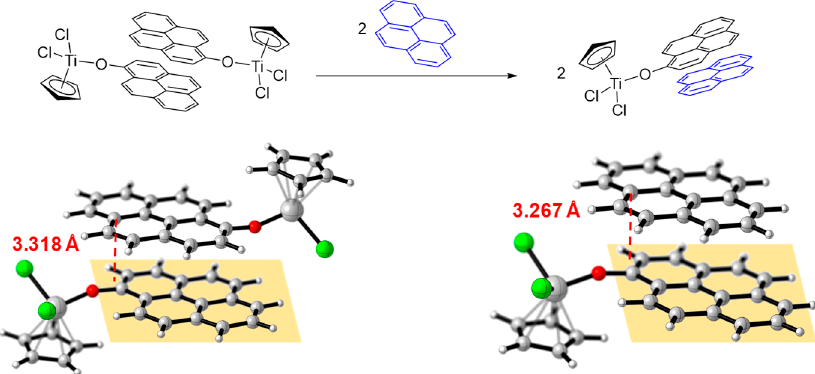
Scheme 3. Illustrative scheme for the formation of π , π -stacking between complex Ti3 and externally added pyrene molecule (structures of π , π -stacked dimer of complex Ti3 and Ti3 -pyrene were